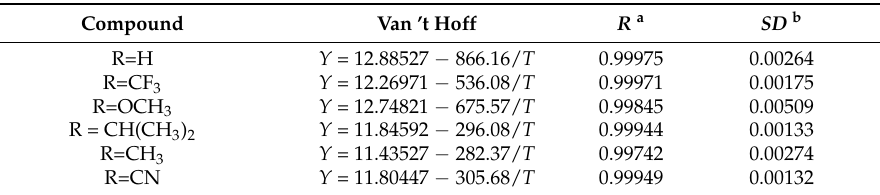
Table 4. Van ’t Hoff plots of PDQL-HSA systems.